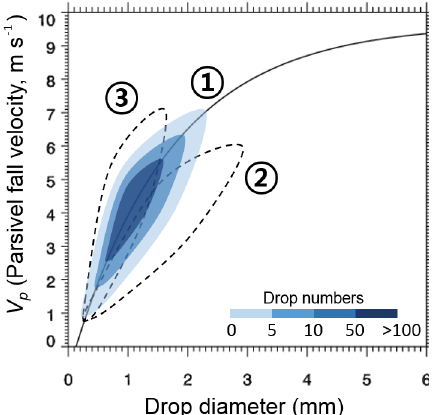
Figure 3. Schematic of Parsivel-measured diameter and fall veloc- ity distributions for the three cases of determining zero w , upward w , and downward w . Solid line curve indicates terminal fall ve- locities ( V f ) computed from Eq. (1). Contours show drop number concentrations. See text for more